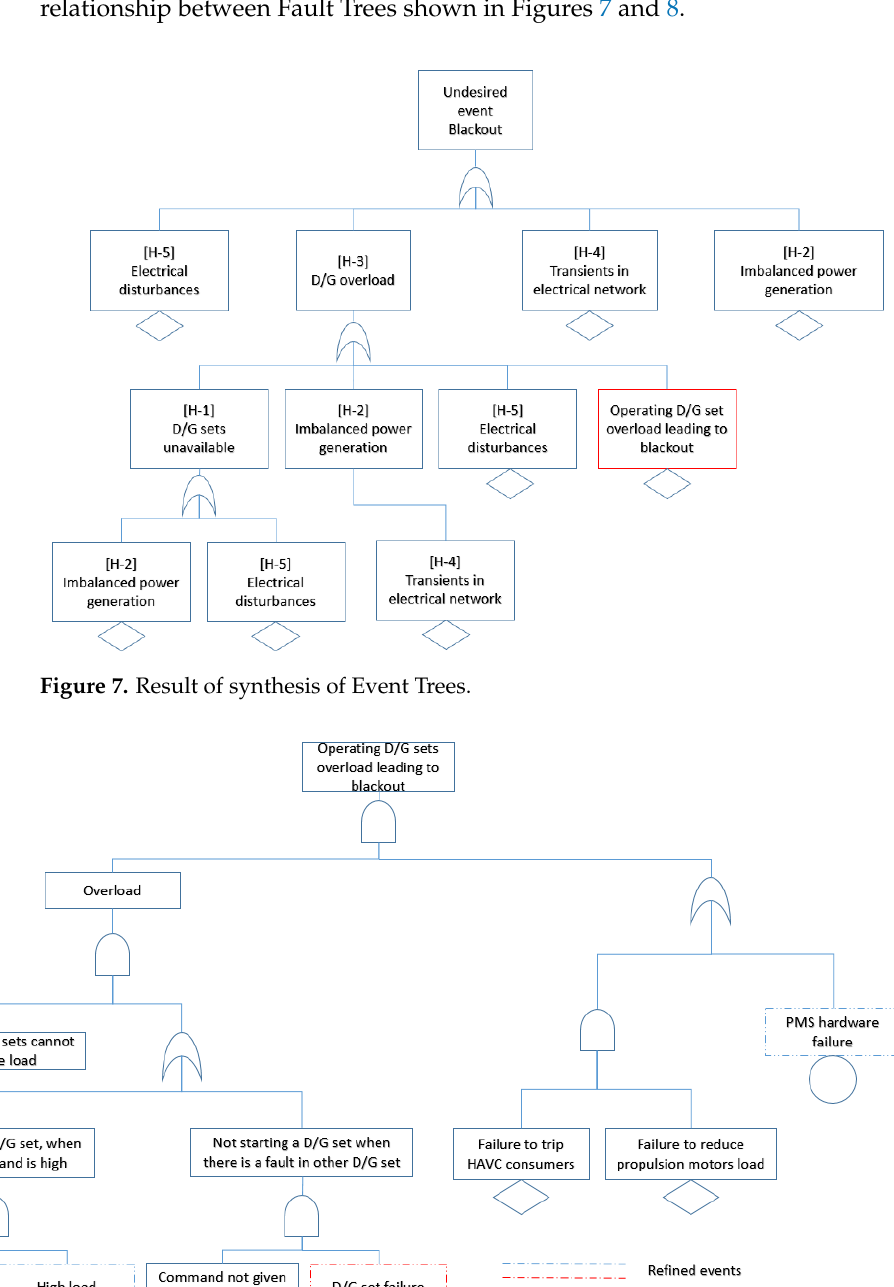
Figure 7. Result of synthesis of Event Trees.